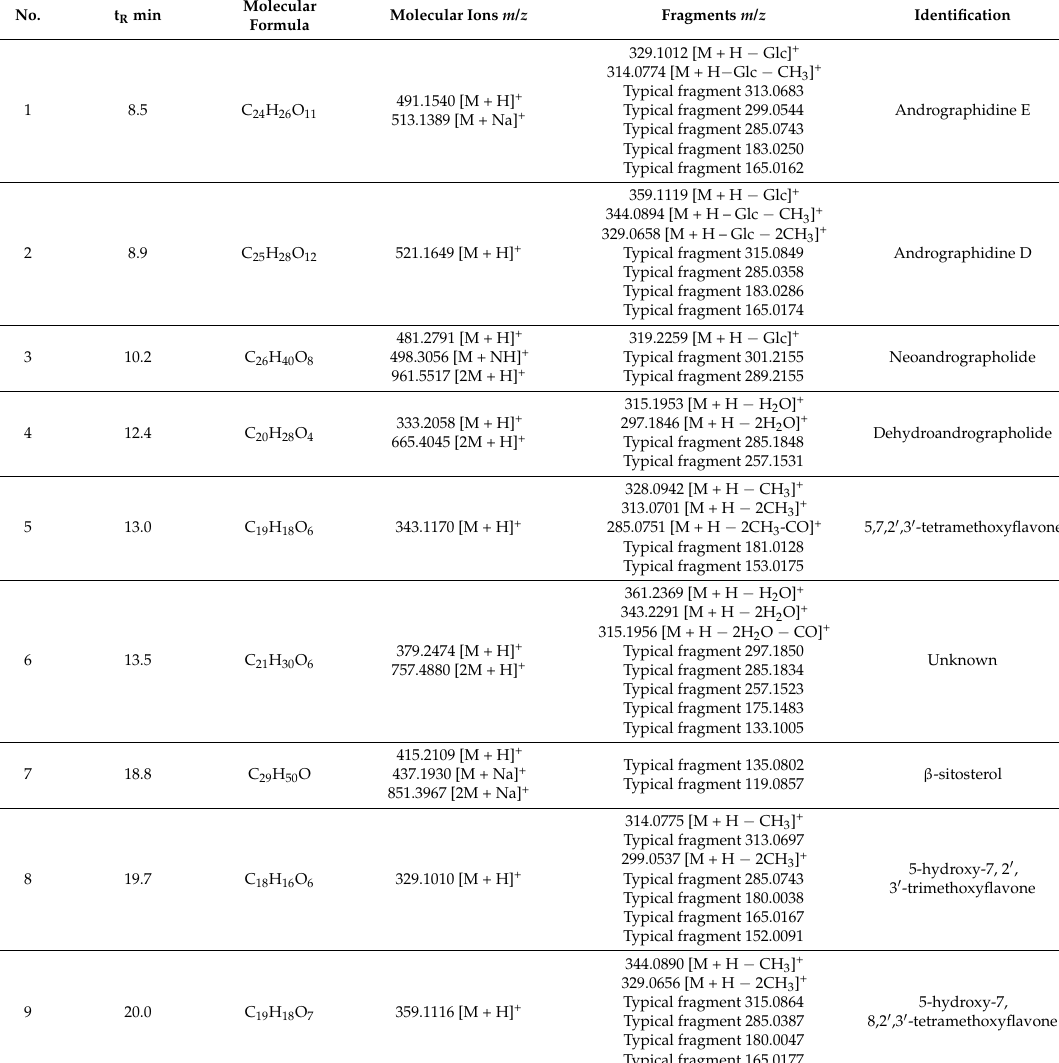
Table 1. Characteristics of potential bioactive compounds from AH by UPLC/Q-TOF-MS. No. t R min Molecular Formula Molecular Ions m /